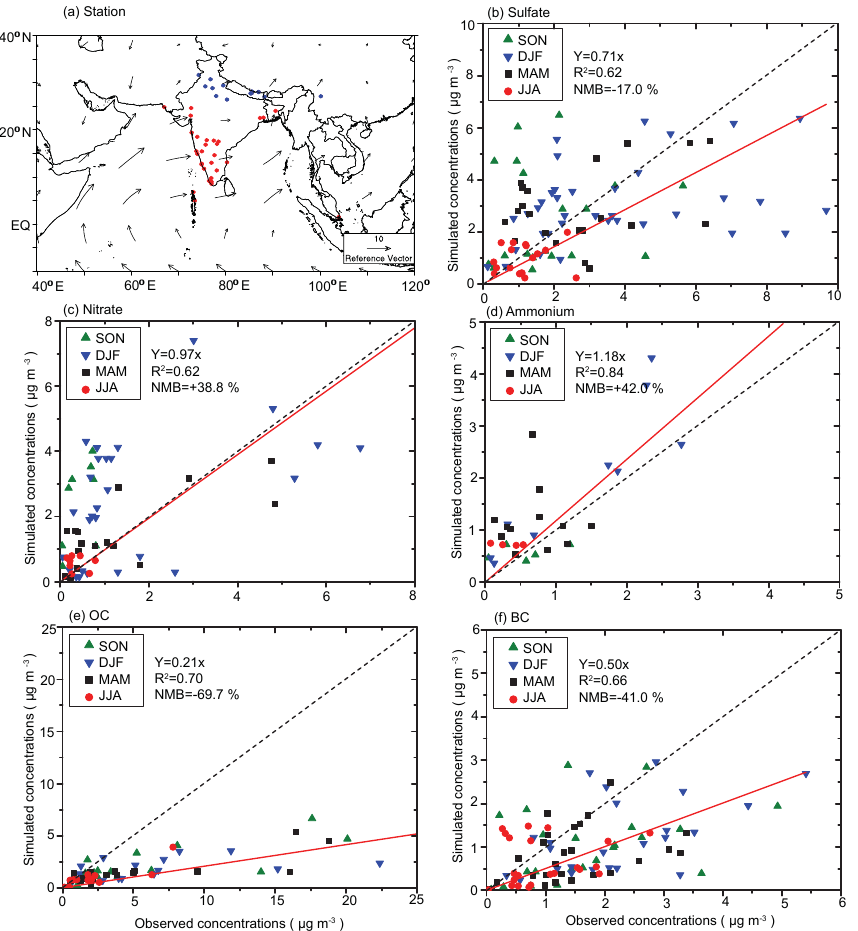
Figure 8. (a) Locations with measured aerosol concentrations from previous studies. Surface winds during summertime are also shown. Panels (b) – (f) show the comparisons of simulated seasonal mean concentrations of sulfate, nitrate, ammonium, OC, and BC with measured values, respectively. In (b) – (f) the 1:1 line (dashed), linear fit (solid line and equation), correlation coefficient between simulated and measured concentrations ( R ), and normalized mean bias (NMB) (defined as NMB = and observed concentrations at station i for each aerosol species) are also